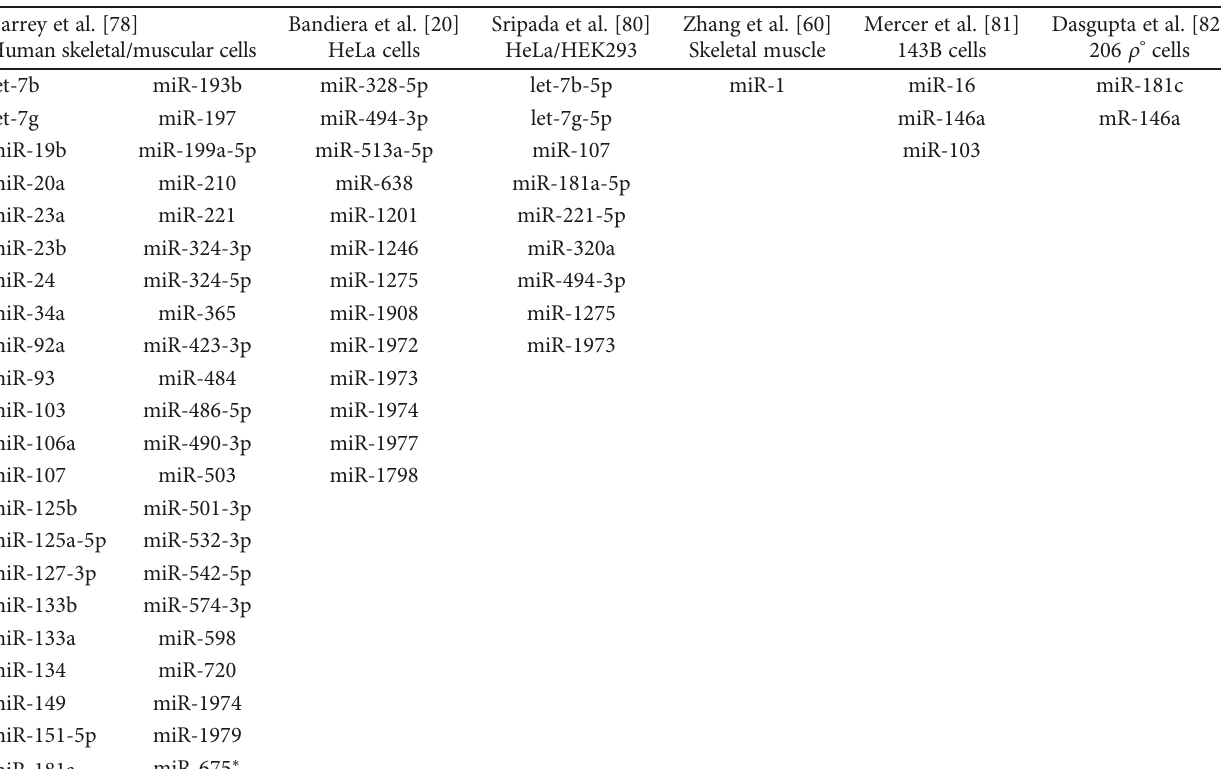
Table 1: List of miRs within human